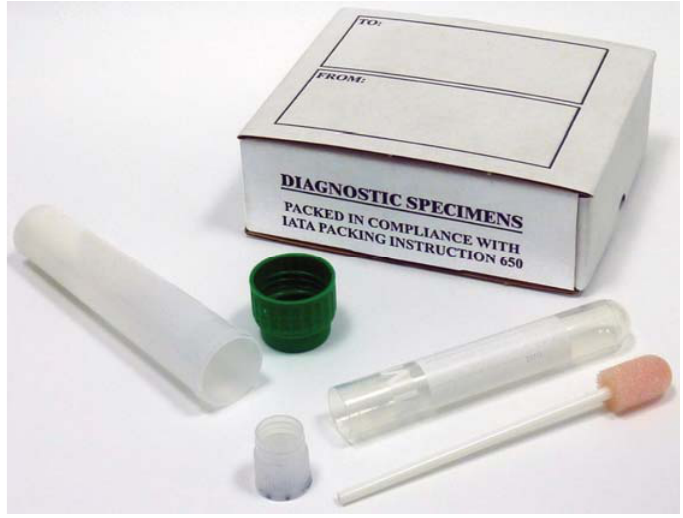
Figure 1. A mumps oral fluid collection kit comprising Oracol collection swab and transport packaging.